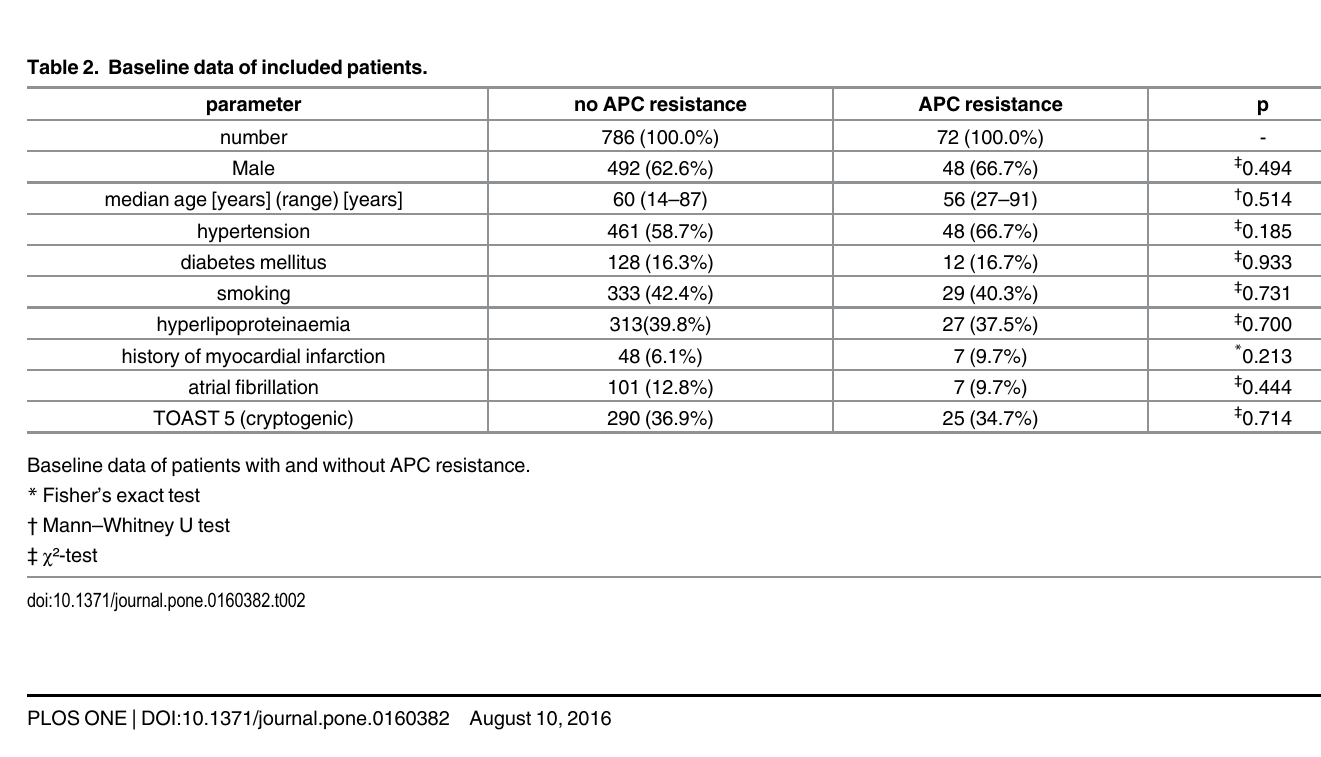
Baseline data of patients with and without APC resistance The study cohort was subdivided into two groups according to the presence or absence of APC resistance. Comparison of baseline data shown in Table 2 did not reveal any significant differences.